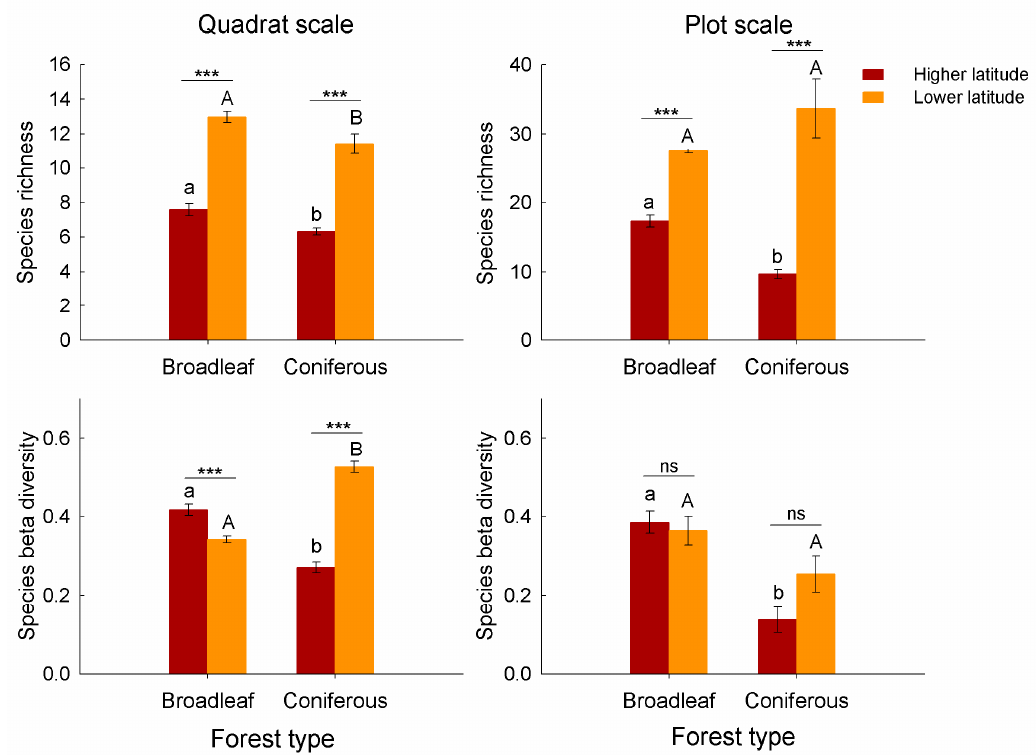
Figure 2. Species alpha and beta diversity of understory communities under different forest types (broadleaf vs. coniferous) and latitudes (higher vs. lower) at the quadrat and plot scales. Species alpha diversity is measured as species richness, and beta diversity is estimated with the Sørensen dissimilarity. Different small letters (a, b) indicate significant differences ( p < 0.05) between broadleaf and coniferous forests at the higher latitude, while different capital letters (A, B) represent significant differences at the lower latitude. The differences in diversity between the two latitudes were either highly significant with p < 0.001 (***) or not significant with p > 0.05 (ns).